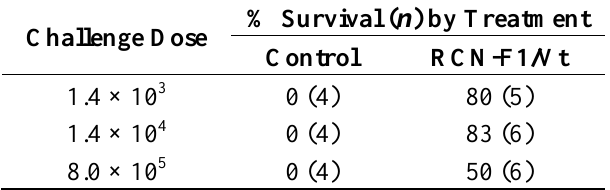
Table 2. Survival rates of A/J mice vaccinated with RCN F1/Vt and challenged with Y. pestis. Challenge